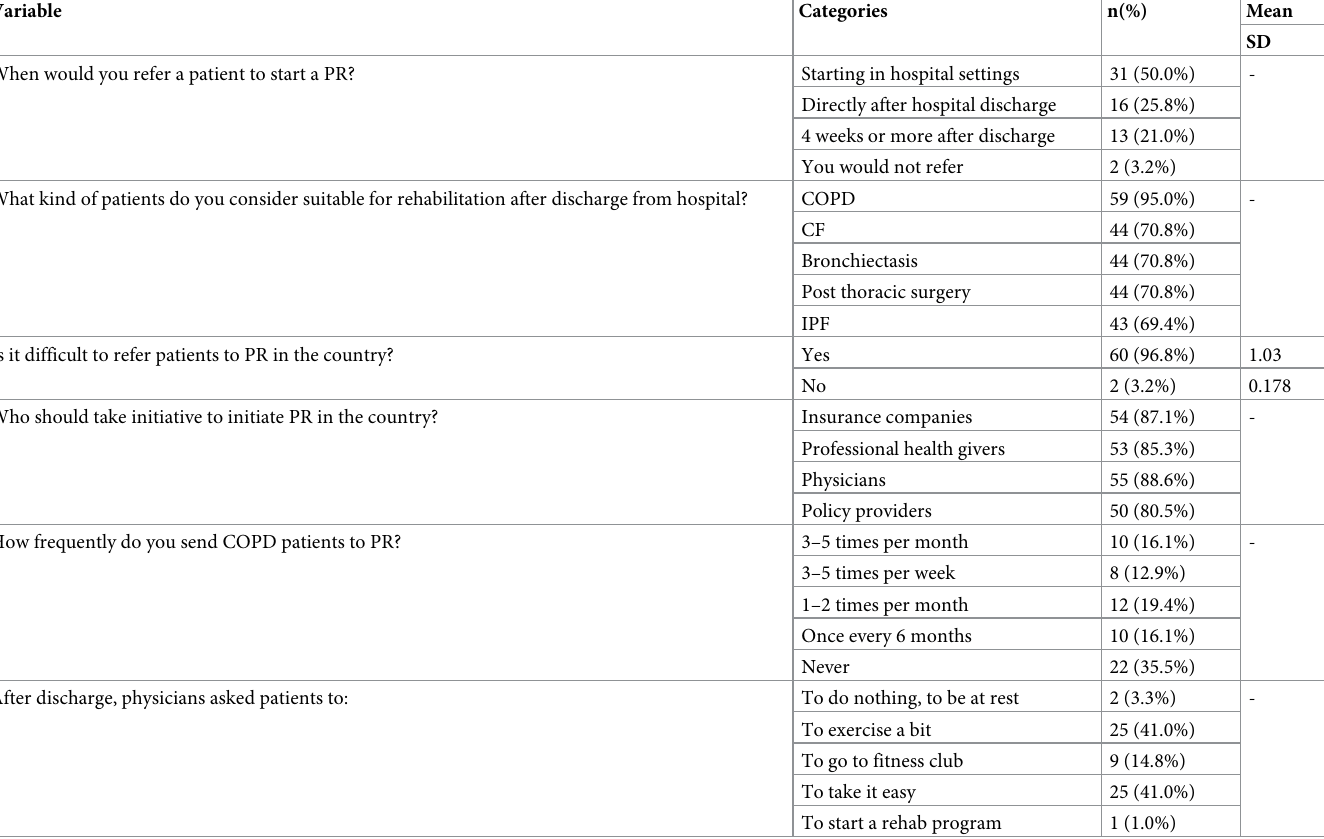
Table 4. Practice of chest physicians regarding pulmonary rehabilitation (PR), N = 62.